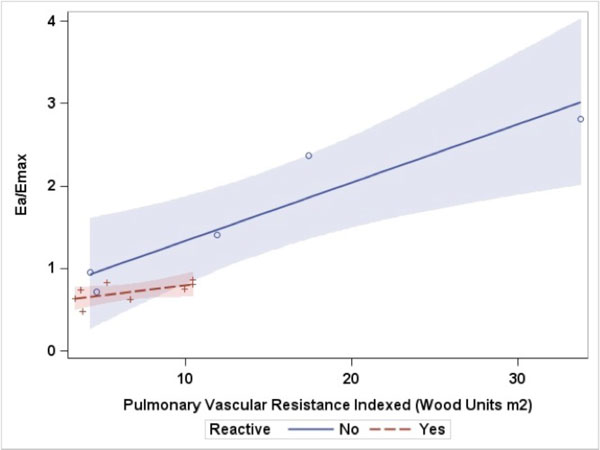
Regression of ventricular arterial coupling ratio (Ea/Emax) and pulmonary vascular resistance indexed by reactivity. The shaded areas represent the 95% confidence interval for each regression line. The lines depict different trajectories based on reactivity, which approached, but not reach statistical significance (p > 0.05).